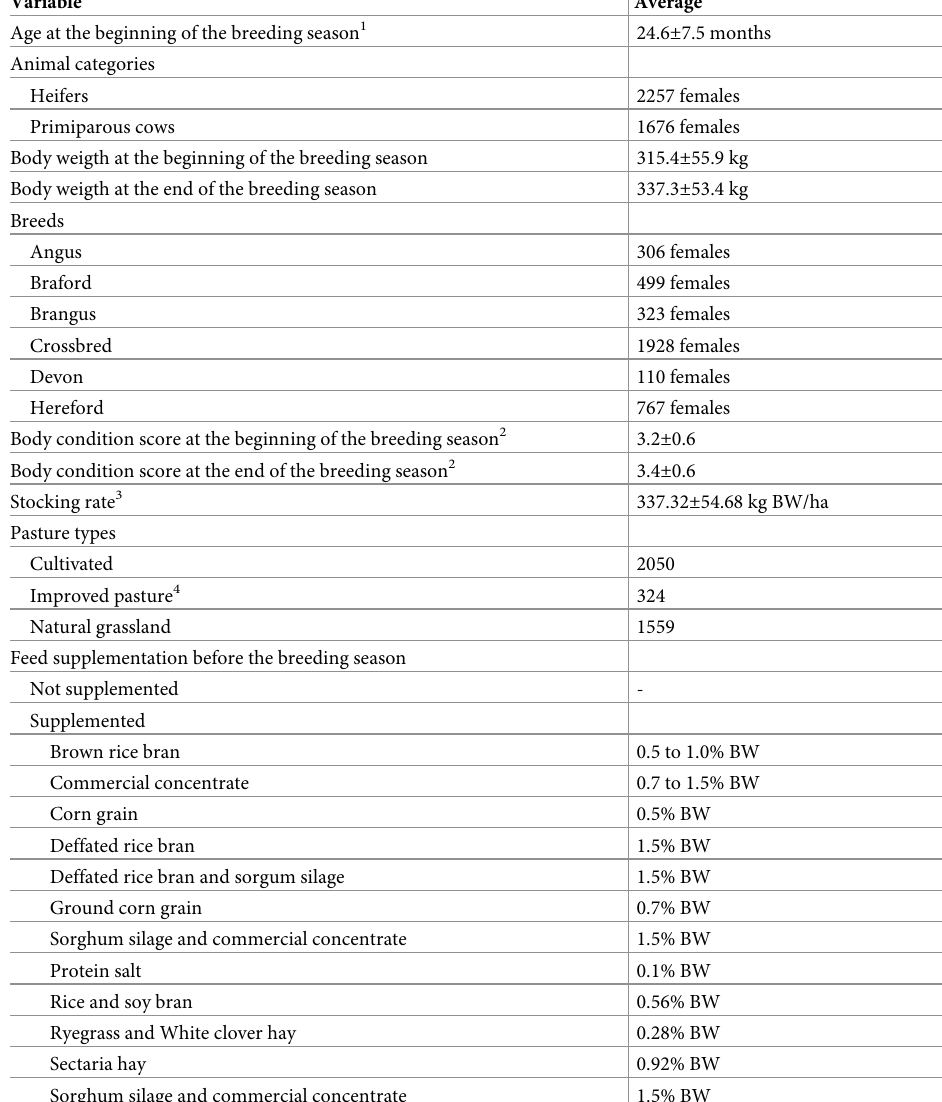
Table 2. Average and standard error of each variable in the initial database.